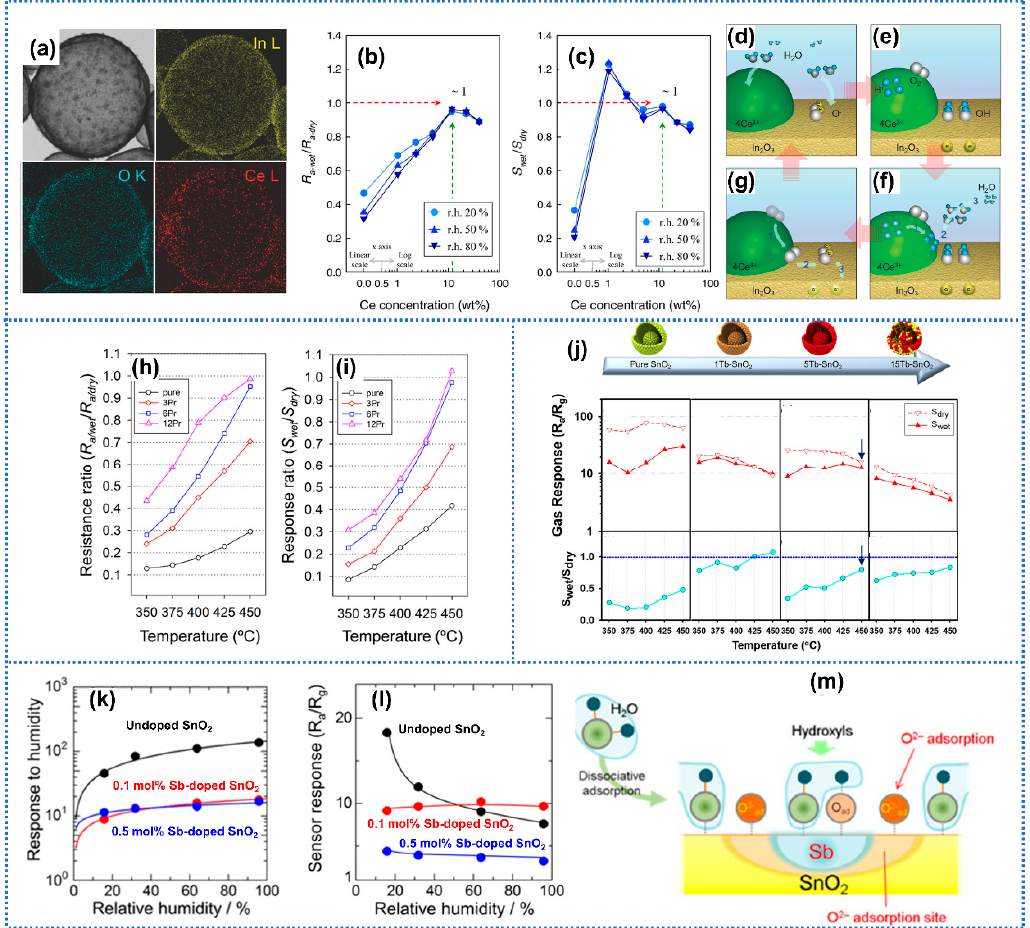
Figure 4. ( a ) Elemental mapping of 11.7 Ce-In 2 O 3 hollow spheres. ( b ) R a-wet /R a-dry and ( c ) S wet /S dry of pure and Ce-In 2 O 3 hollow spheres exposed to 20 ppm acetone at 450 ◦ C. ( d – g ) Illustrations of the self-refreshing In 2 O 3 sensing surface by the CeO 2 nanoclusters ( d ) water vapor inflow, ( e ) chemisorption, ( f ) desorption, and ( g ) oxygen ion regeneration. Reprinted with permission from Ref. [70]. Copyright 2016, Wiley. ( h ) Resistance ratios (R a/we t/R a/dry ) and ( i ) response ratios (S wet /S dry ) of pure 3Pr − , 6Pr − , and 12Pr − In 2 O 3 macroporous spheres at 20 ppm acetone measured in the range of 350–450 ◦ C (dry: RH = 0%, wet: RH = 80%). Reprinted with permission from Ref. [71]. Copyright 2019, American Chemical Society. ( j ) Gas responses to 20 ppm acetone of pure SnO 2 , 1Tb − SnO 2 , 5Tb − SnO 2 , and 15Tb − SnO 2 sensors in the presence of various gases at 350, 375, 400, 425, and 450 ◦ C under dry and 80% RH conditions. Reprinted with permission from Ref. [73]. Copyright 2018, American Chemical Society. ( k ) The humidity dependence of response to humidity at 350 ◦ C and ( l ) humidity dependence of response to 200 ppm H 2 at 350 ◦ C of undoped SnO 2 , 0.1 mol% Sb-doped SnO 2 , and 0.5 mol% Sb-doped SnO 2 . ( m ) Schematic model of hydroxyl and oxygen coadsorption on Sb-SnO 2 . Reprinted with permission from Ref. [75]. Copyright 2016, American Chemical